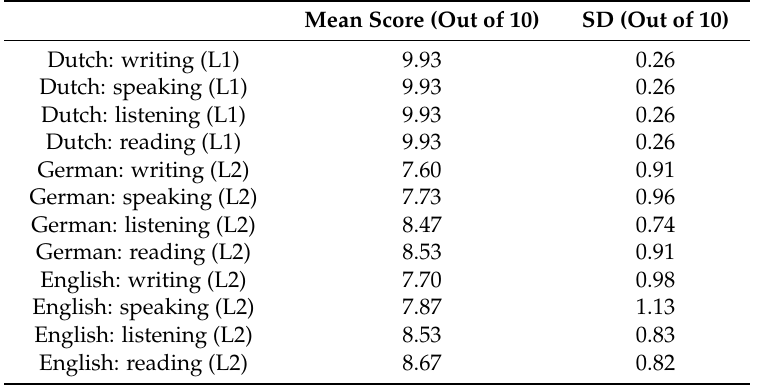
Table 1. Self-rated proficiency scores for the Dutch-German multilingual group.